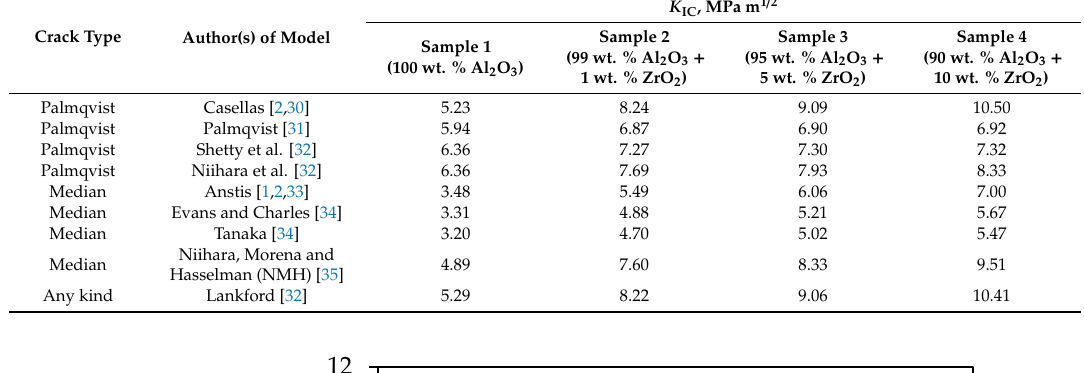
Table 8. Values of the Vickers indentation fracture toughness for di ff erent crack type and models.